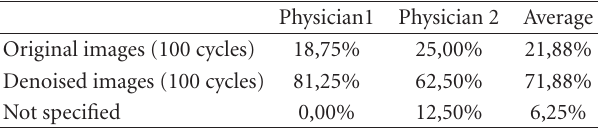
Table 3: Example of statistics obtained by tests of forced choice.